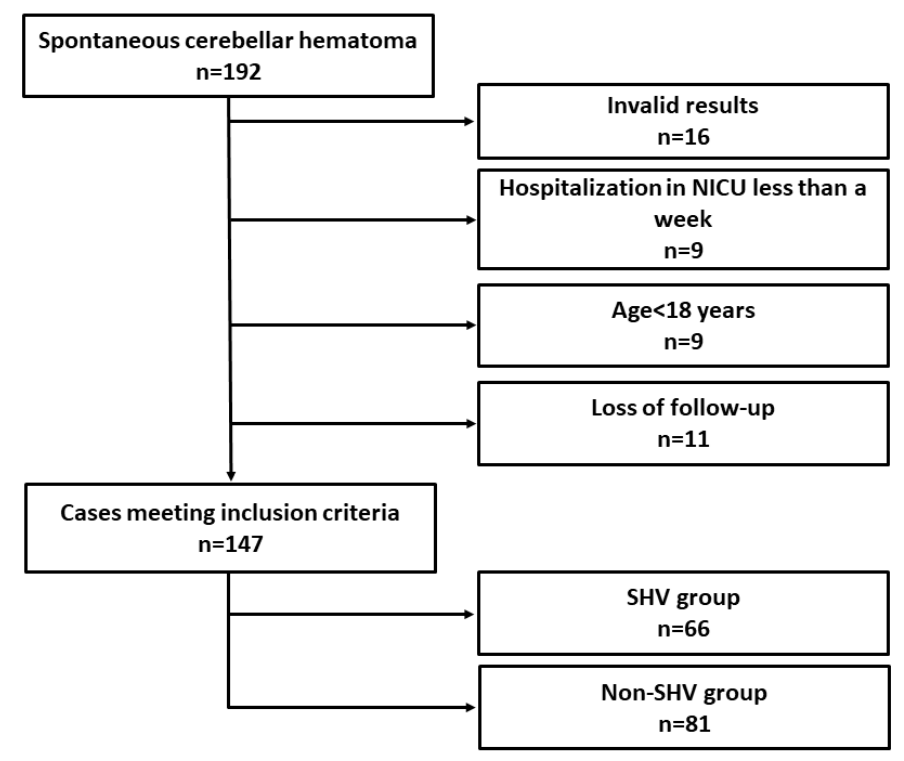
Figure 1. Flowchart of study cases satisfying the inclusion criteria. NICU, neurointensive care unit; SHV, spontaneous hyperventilation.